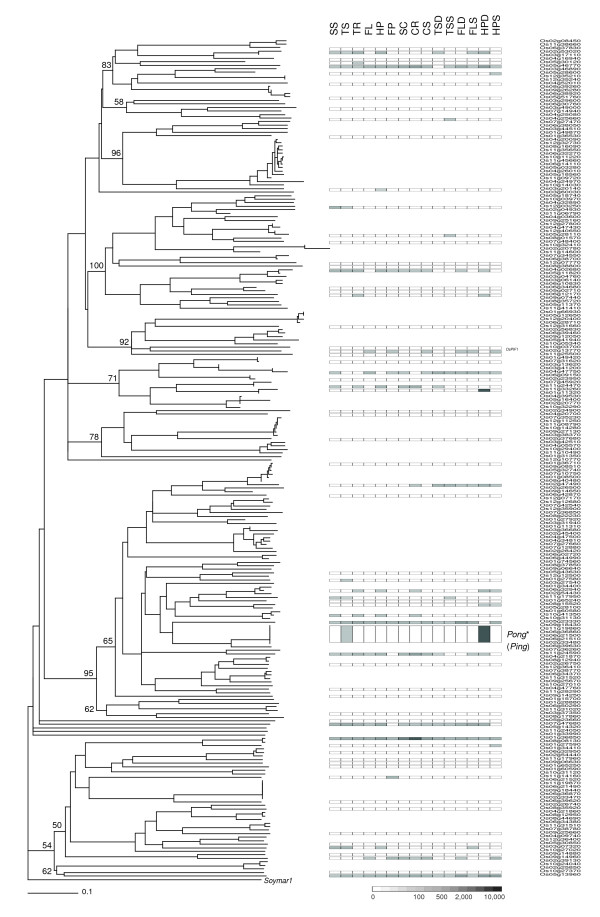
Degrees of lineage-specific transcription in PIF/Pong-like superfamily. The phylogenetic tree was generated from a multiple alignment of conceptually translated sequences by using neighbor-joining methods and rooted with soybean Soymar1. Bootstrap values were calculated from 1,000 replicates. Sample numbers are identical to those in Table 2. Shades of gray indicate the magnitude of transcription signals, which are based on microarray hybridization signals without units. Names of previously reported members are shown. Names in parenthesis indicate members not covered by the microarray. *Previously reported members with transcriptional or transpositional activity.